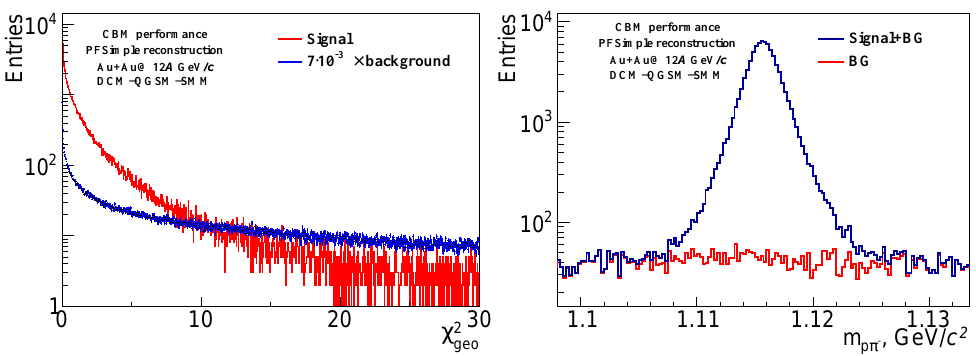
Figure 2. ( left ) Distribution of the χ 2 geo for Λ → p π − candidates selected using criteria for χ 2 , L / ∆ L , and cos α Λ p listed in Table 1. No event or Λ candidate kinematical selection. ( right ) prim Invariant mass distribution for all (blue) and combinatorial background (red) Λ candidates.